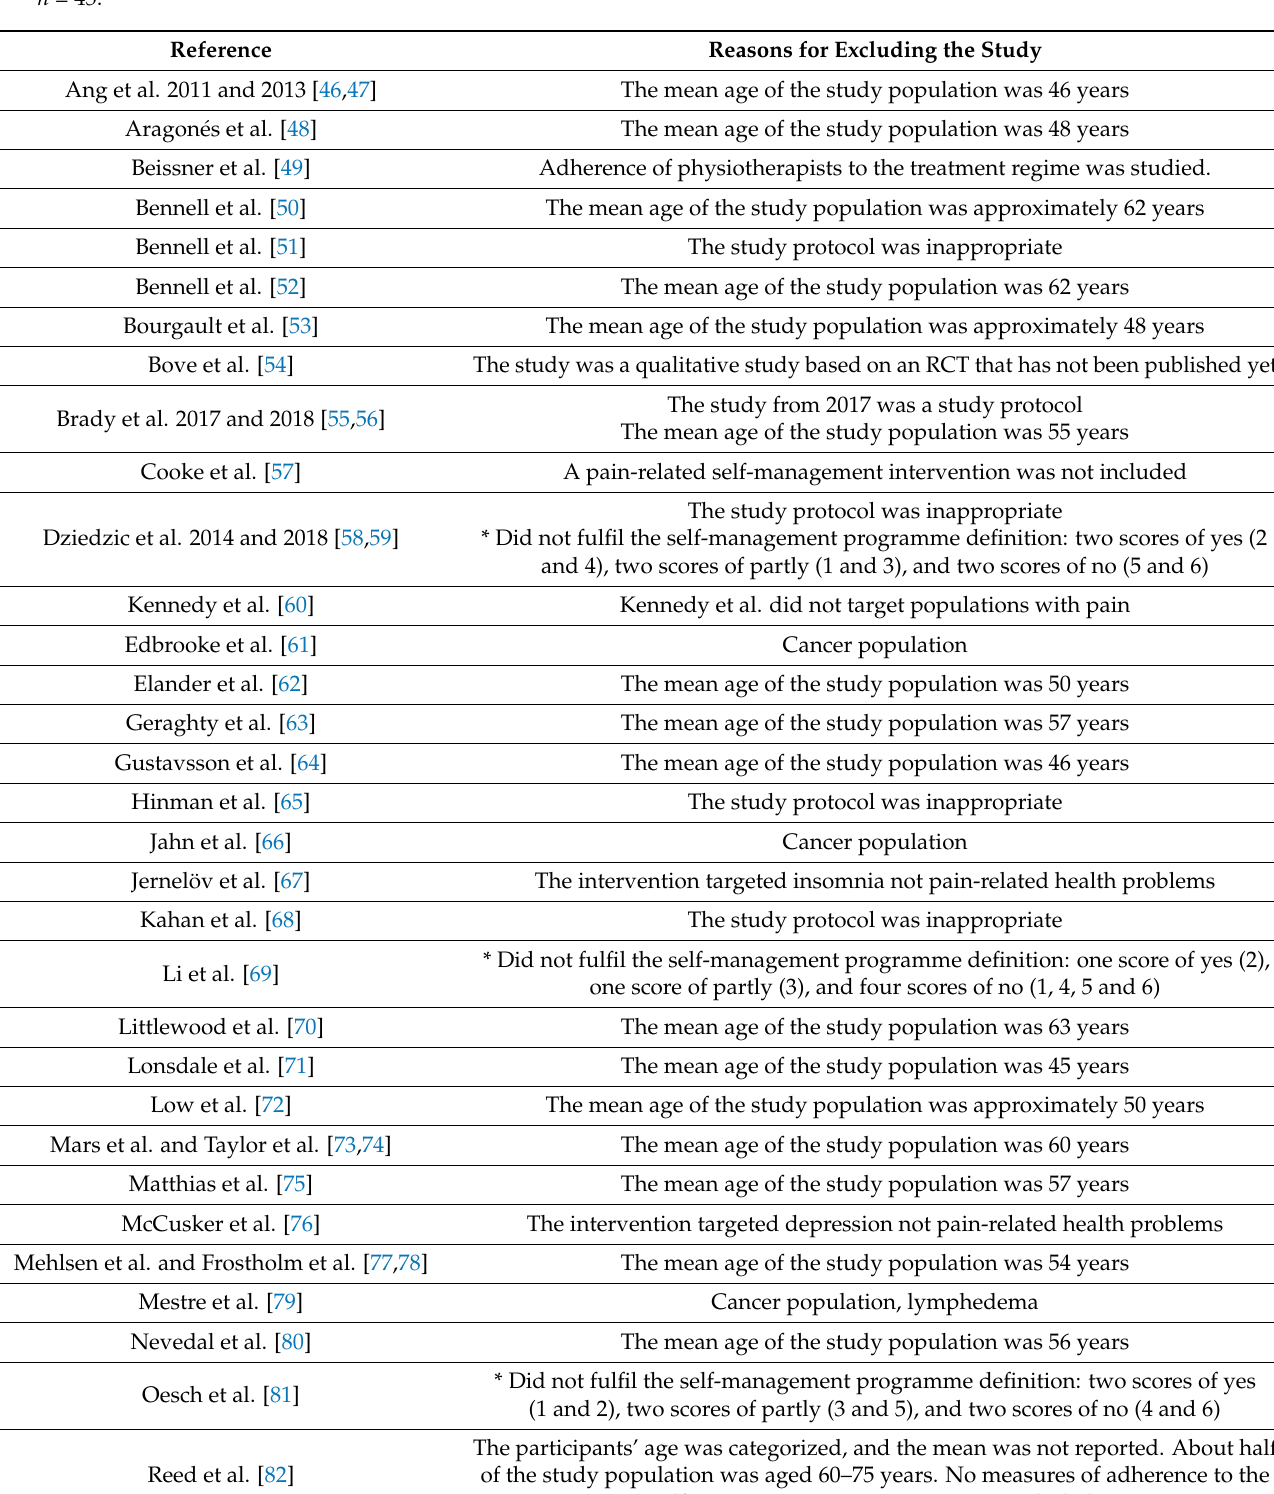
Table A1. The excluded full-text papers regarding adherence to and the maintenance of pain self-management programmes in older adults with musculoskeletal pain who were included in randomized controlled trials. n = 39. Six studies required an additional two references because we needed to determine the details of the study and inclusion/exclusion criteria. Total n =